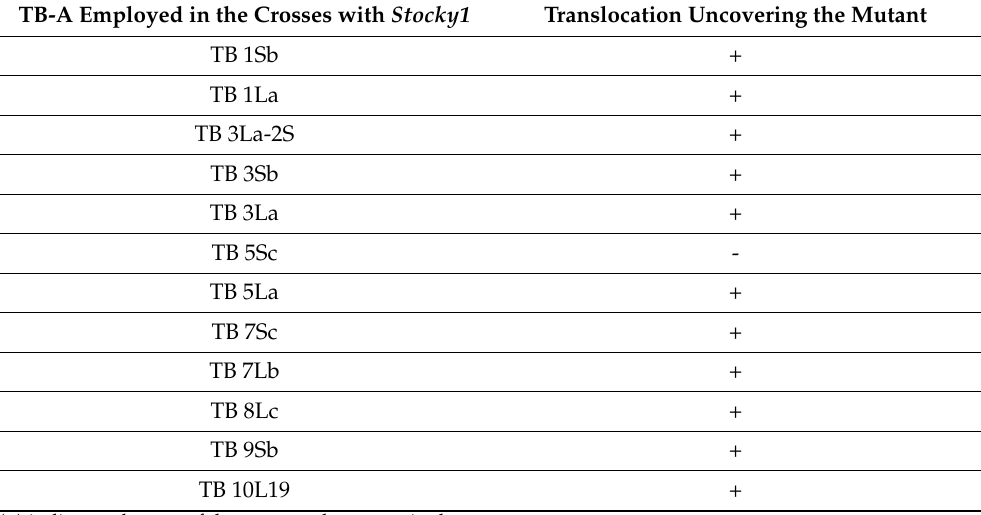
Table 3. Result of TB-A crosses with stocky1